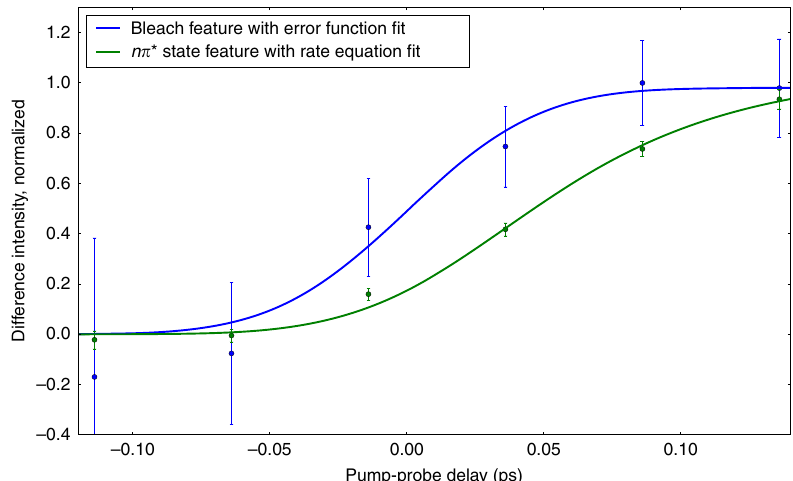
Fig. 3 Delay between the onsets of ground-state bleach and excited-state signature. The experimental data for the bleach signal ( blue ) are extracted from a region of interest in the Auger spectra from the photon energy region, where the bleach is observable in the near-edge absorption fi ne structure spectra. For better comparison with the corresponding data set from the region of the n π * feature ( green ), the bleach data set is inverted. Both data sets are normalized to the maximum modulation. The time-dependence of the n π * feature is fi tted with the rate equation model. The delay between the bleach and the n π * feature is clearly visible. All error bars represent the standard error of